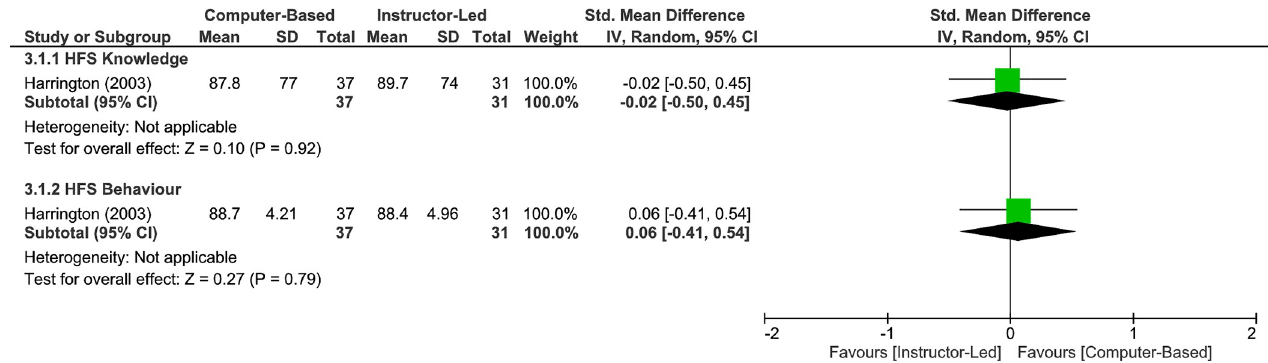
Fig 6. Analysis 3.1.1 Forest plot of comparison: Computer-based vs instructor-led, immediate–adults, outcome: Home fire safety knowledge, 1 RCT. Analysis 3.1.2 Forest plot of comparison: Computer-based vs Instructor-led, Immediate–Adults, outcome: Home Fire Safety Behaviour, 1 RCT. Higher values indicate better/improved